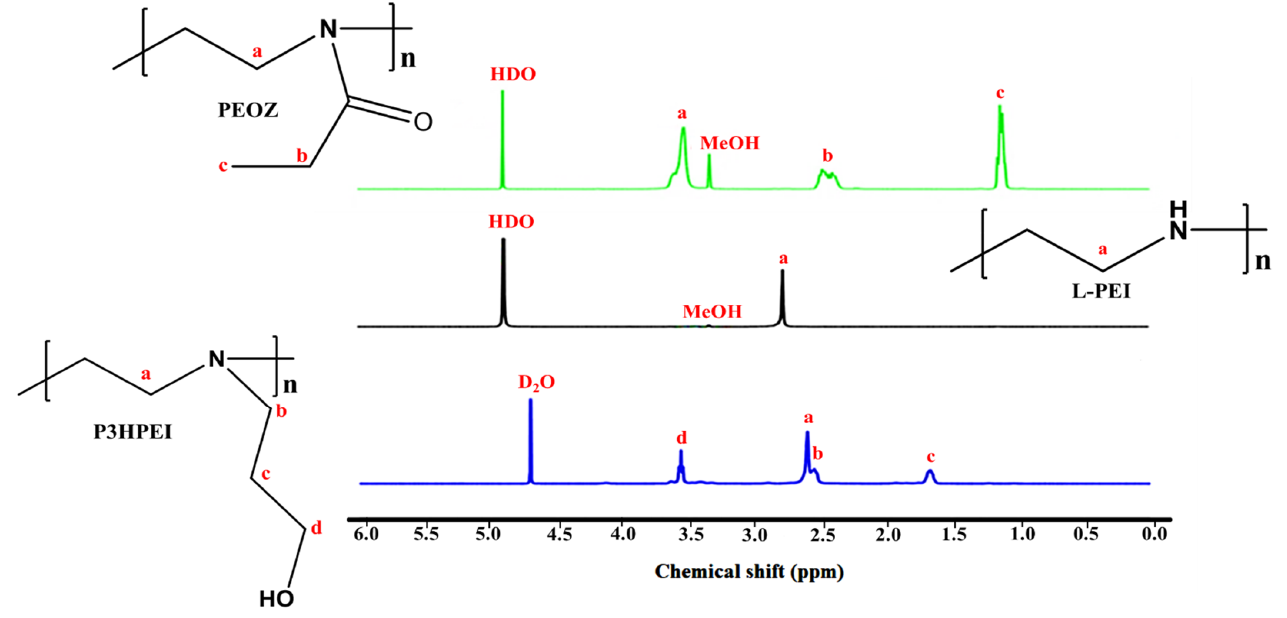
Figure 2. 1 H NMR spectra of PEOZ in MeOH-d 4 , L-PEI in MeOH-d 4 , and P3HPEI in D 2 O.